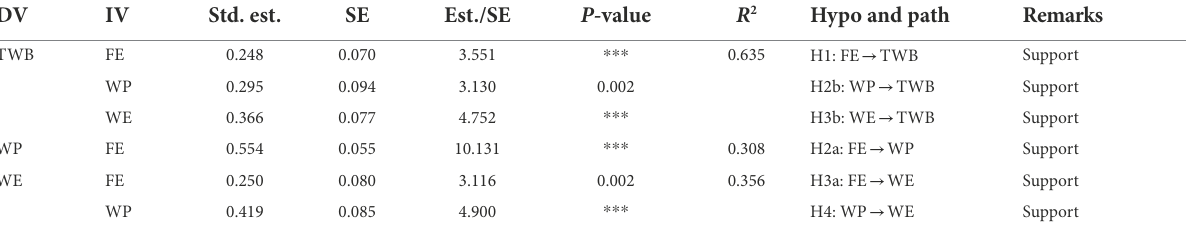
TABLE 4 The direct effect of the research paths and research model hypothesis analysis.